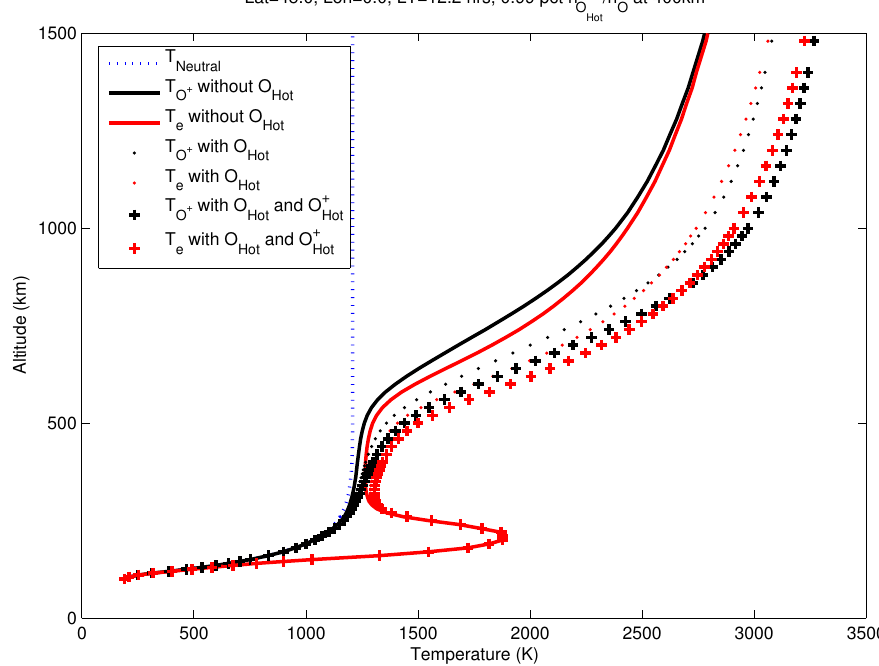
Fig. 3. Comparison of temperatures calculated by TRANSCAR for 3 different simulations: control sim., sim. with hot O, and sim. with hot O and hot O + . T Neutral is the cold neutral temperature, T O + is the O + temperature, and T e is the electron temperature.